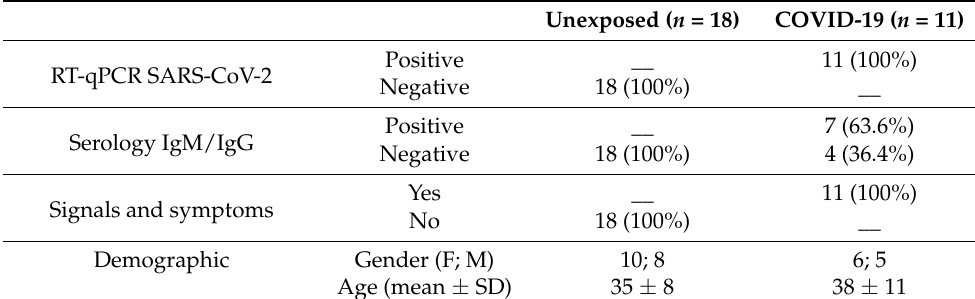
Table 2. Descriptive frequencies of clinical